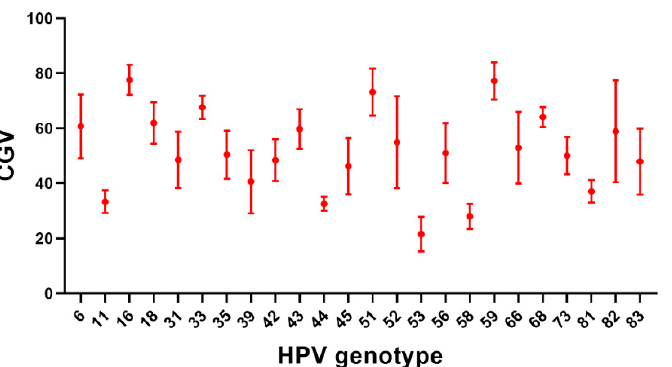
Figure 6. Test results of 24 simulated HPV genotype samples at the same concentration in the microfluidic system. The CGV results of 24 HPV genotypes while the sample concentration is 10 3 copies/mL.